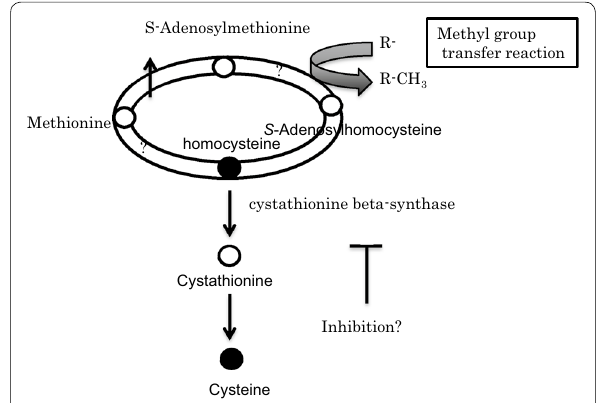
Fig. 2 Changes in the methionine cycle after addition of agmatine. ○ ↑ : Up regulated by agmatine. ● ↓ : Down regulated by